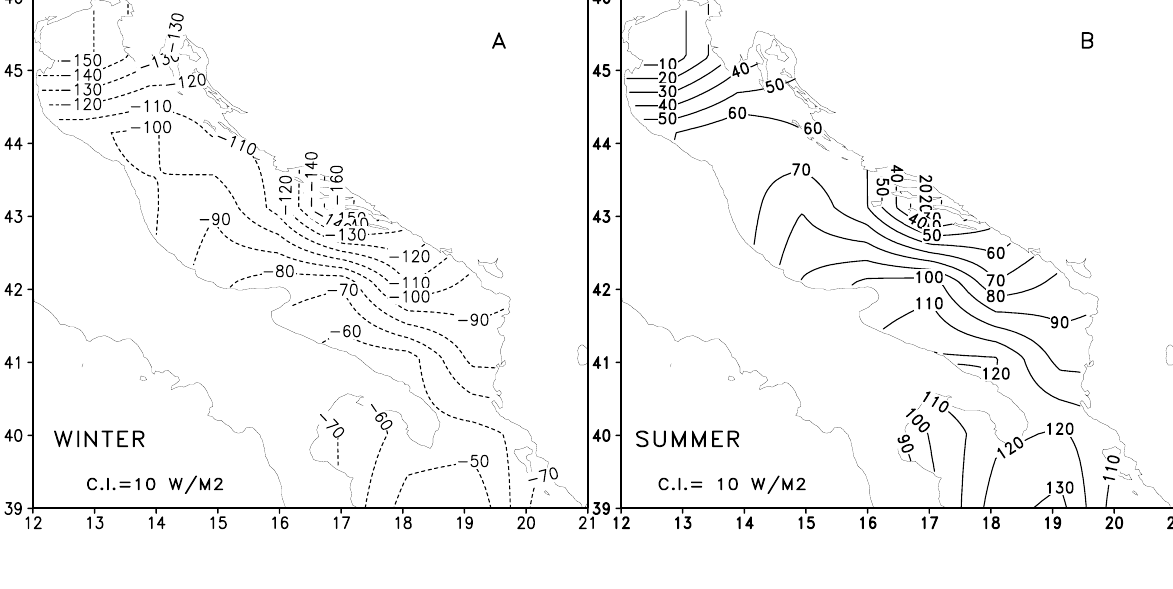
Fig. 3. Seasonal climatological surface heat flux interpolated in the AIM grid. (A) : winter, (B) : summer. Contour interval is 10W/m 2 . Seasons definition as in Artegiani et al. (1997a,